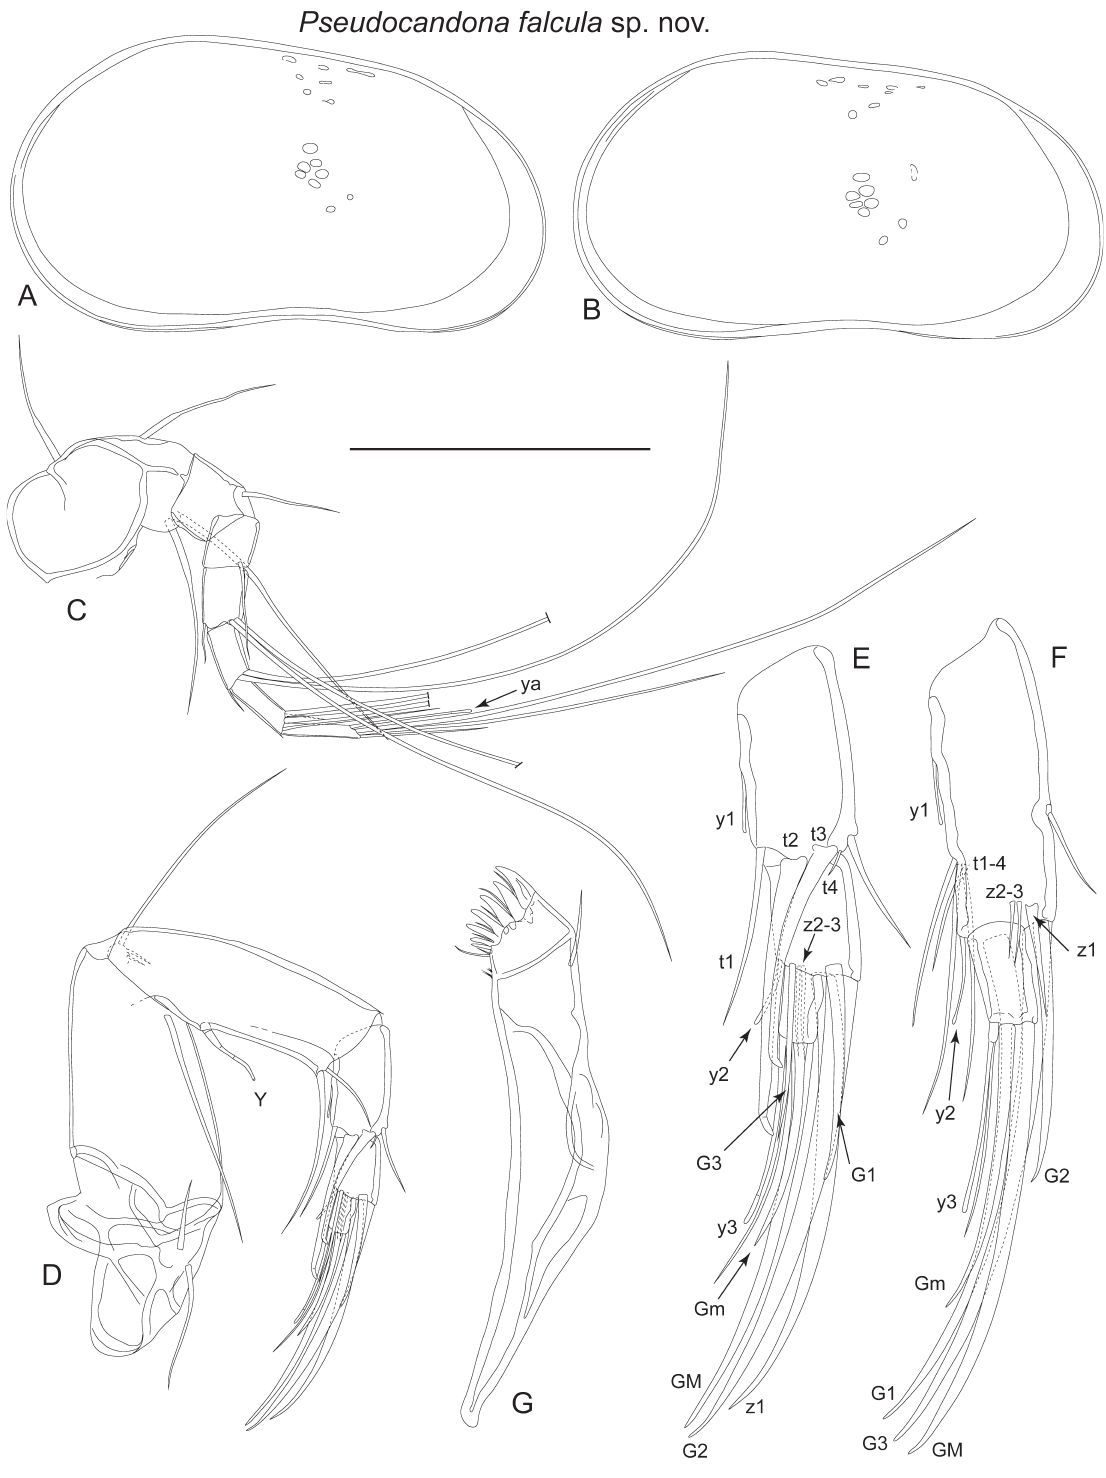
Fig. 11. Pseudocandona falcula sp. nov. A . Internal view of male left valve (LBM 1430006275). B . Internal view of female left valve (LBM 1430006276). C . Male antennule (LBM 1430006275). D . Male antenna (LBM 1430006275). E . Detail of male antenna (LBM 1430006275). F . Detail of female antenna (LBM 1430006276). G . Male mandibular coxa (LBM 1430006275). Scale bar: A–B = 543 µm; C–D, G = 151 µm; E–F = 82